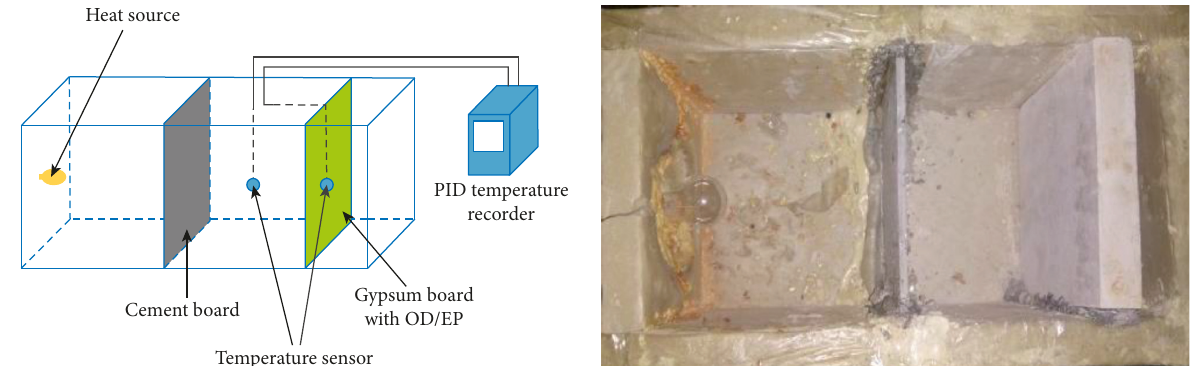
Figure 1: Schematic and design of the instrument used for testing the heat transfer property.